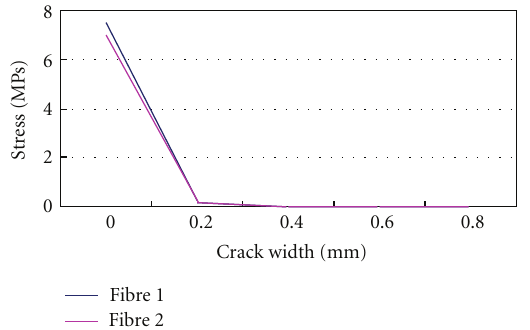
Figure 7: σ -w for concrete with 1kg long fiber.